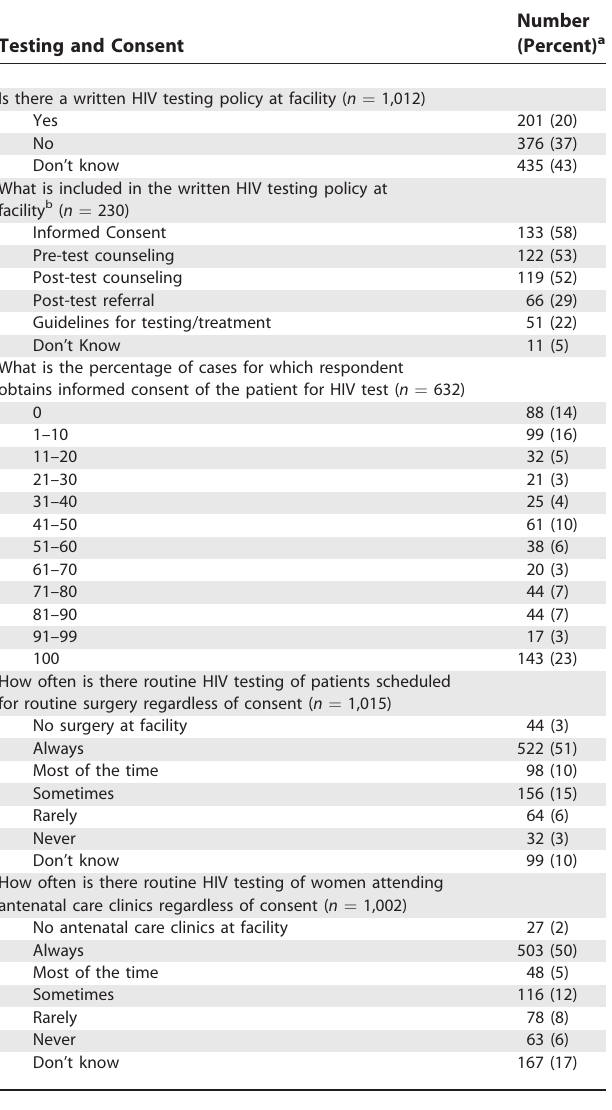
Table 2. Demographic Characteristics among 1,021 Respond- ents